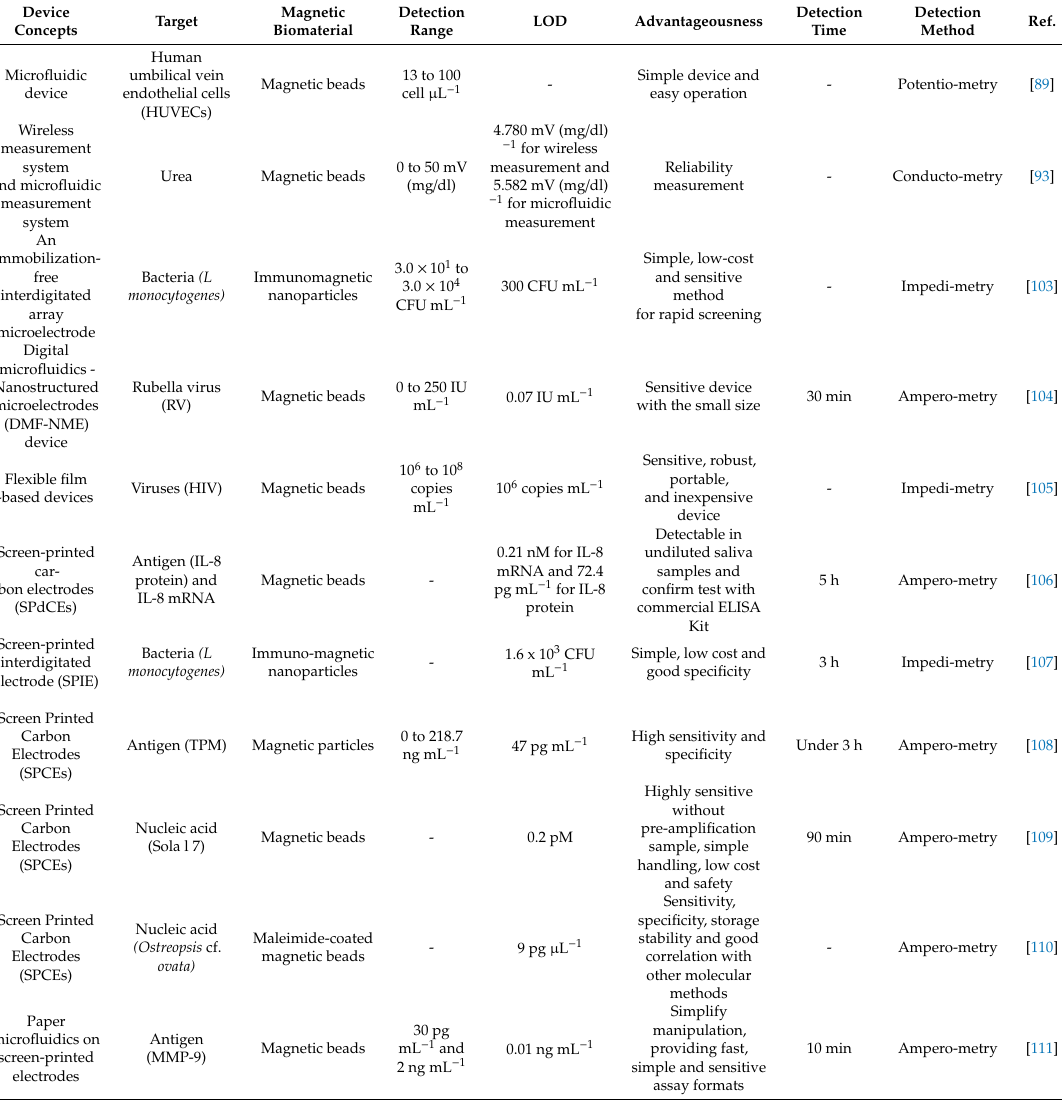
Table 3. Summary of the strategies used for magnetic biomaterials based electrochemical biosensing